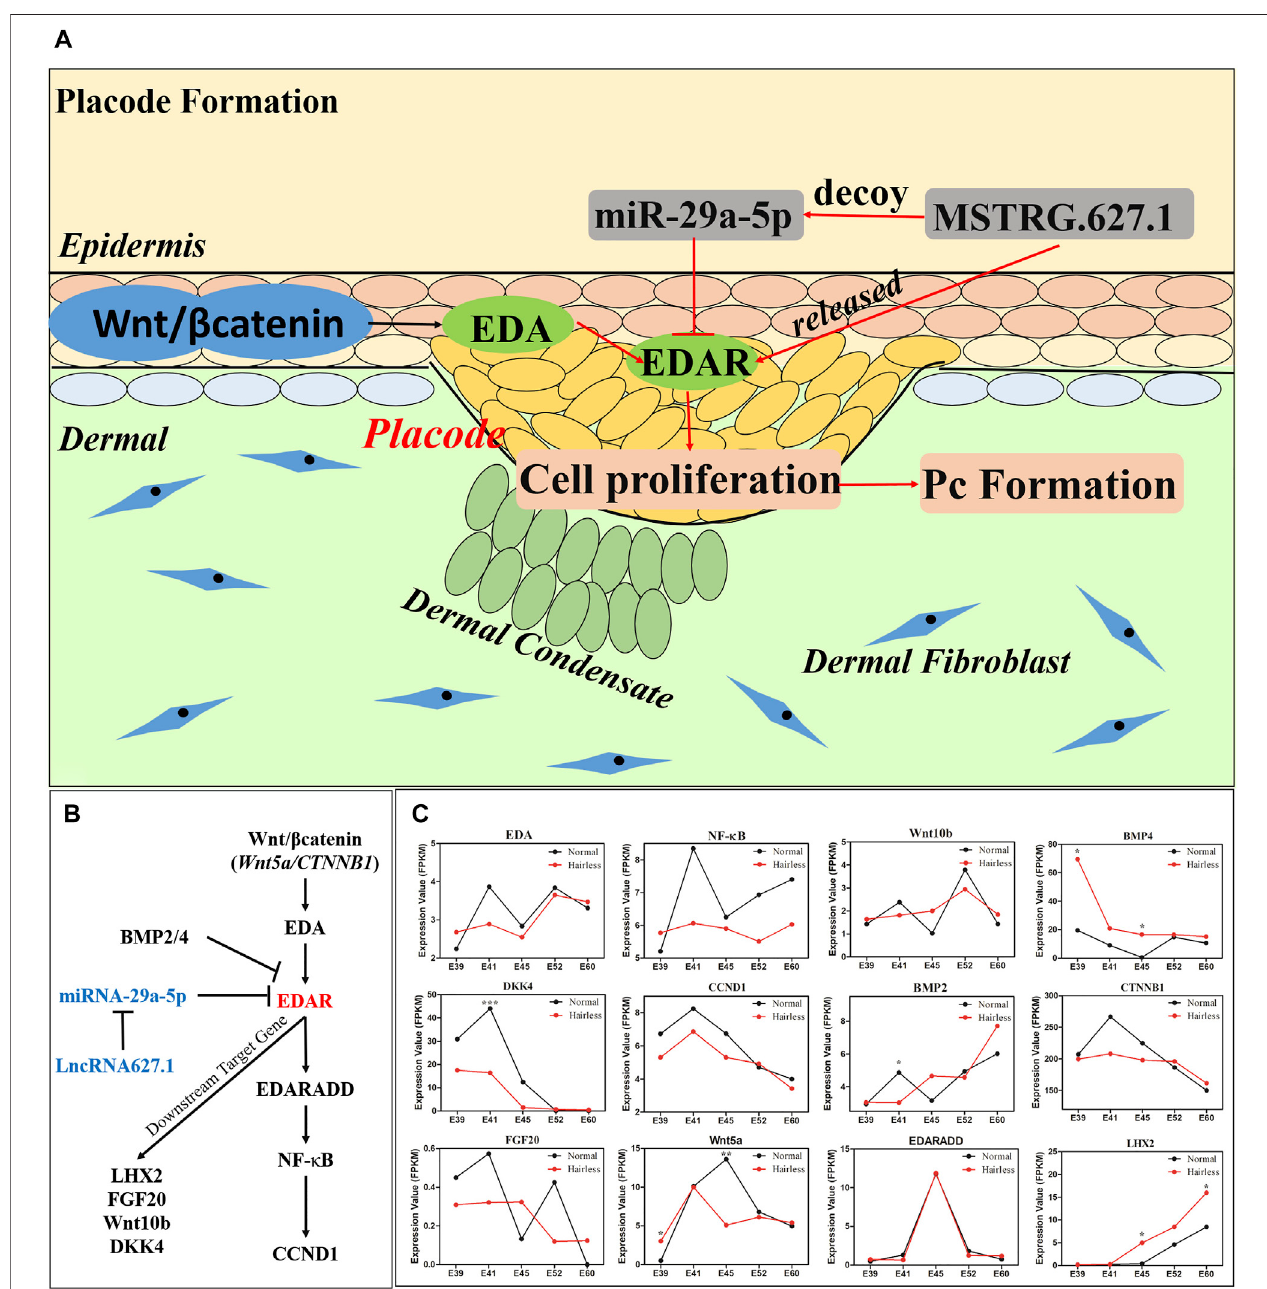
FIGURE 5 | The molecular mechanism of lncRNA627.1/miR-29a-5p/EDAR involved in hair placode formation and expression of EDAR related genes detected in theEDA/EDAR signaling pathway. (A) miR-29a-5p inhibitedcellproliferationtosuppresstheformationofhairplacodesbytargetingEDAR; (B) Schematicillustrating the associationbetweendownstream/upstream target geneexpression andEDARintheEDA/EDAR signalingpathway; (C) Theexpression ofEDARrelatedgenes,Wnt5a, CTNNB1,EDA,EDARADD,NFKB1, CCND1,FGF20,Wnt10b, DKK4,BMP2, and BMP4,innormaland hairlesspigskins,atstages E39,E41,E45,E52,and E60.